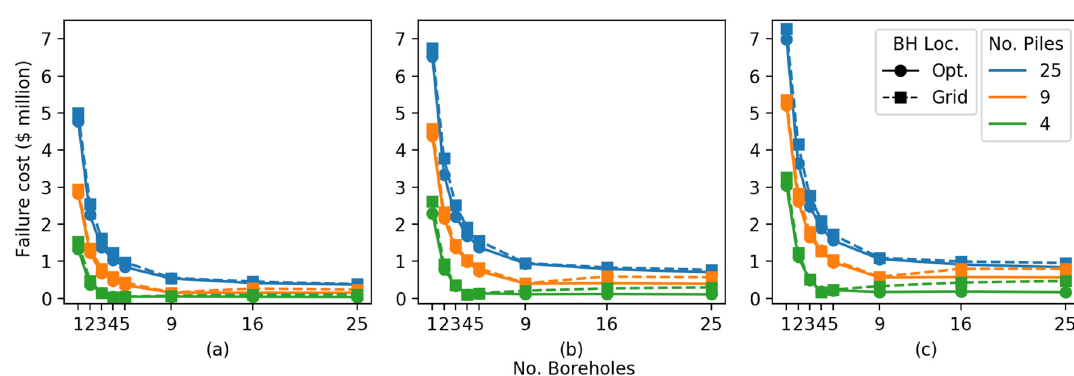
Figure 6. Failure cost comparison between borehole (BH) patterns; a regular grid (Grid) and optimal locations (Opt.) for different numbers of piles, and an SOF of ( a ) 10 m, ( b ) 15 m, and ( c ), 20 m.